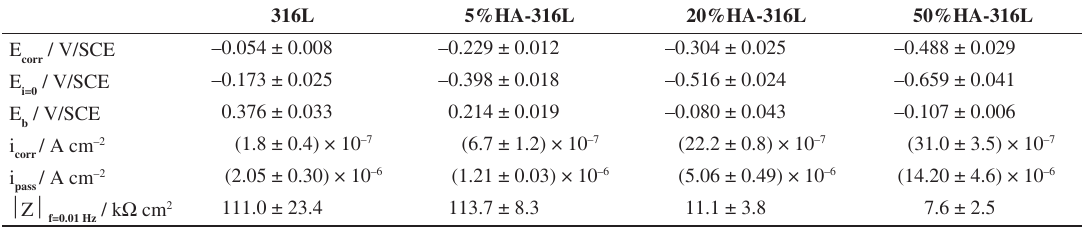
Table 2. Corrosion potential (E ), null‑current potential (E ), breakdown potential (E ), corrosion current density (i corr i=0 b density (i measured at the middle of the passive region) and impedance modulus (|Z| measured at 0.01 Hz) of sintered 316L stainless pass steel and HA‑316L composites in Ringer’s solution at room temperature.